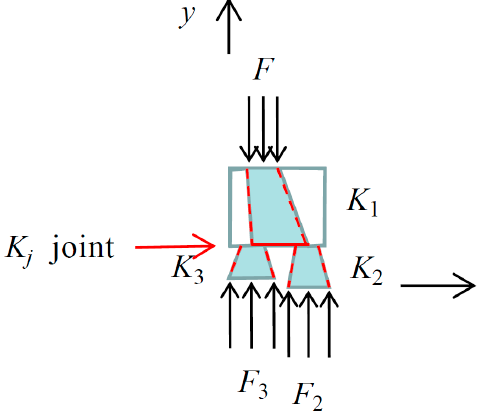
Figure 8. Sketch of the parallel arrangement calculation with different contact areas. According to the method described in the previous section, the deformation of the upper slates and joints can be obtained as follows, respectively: